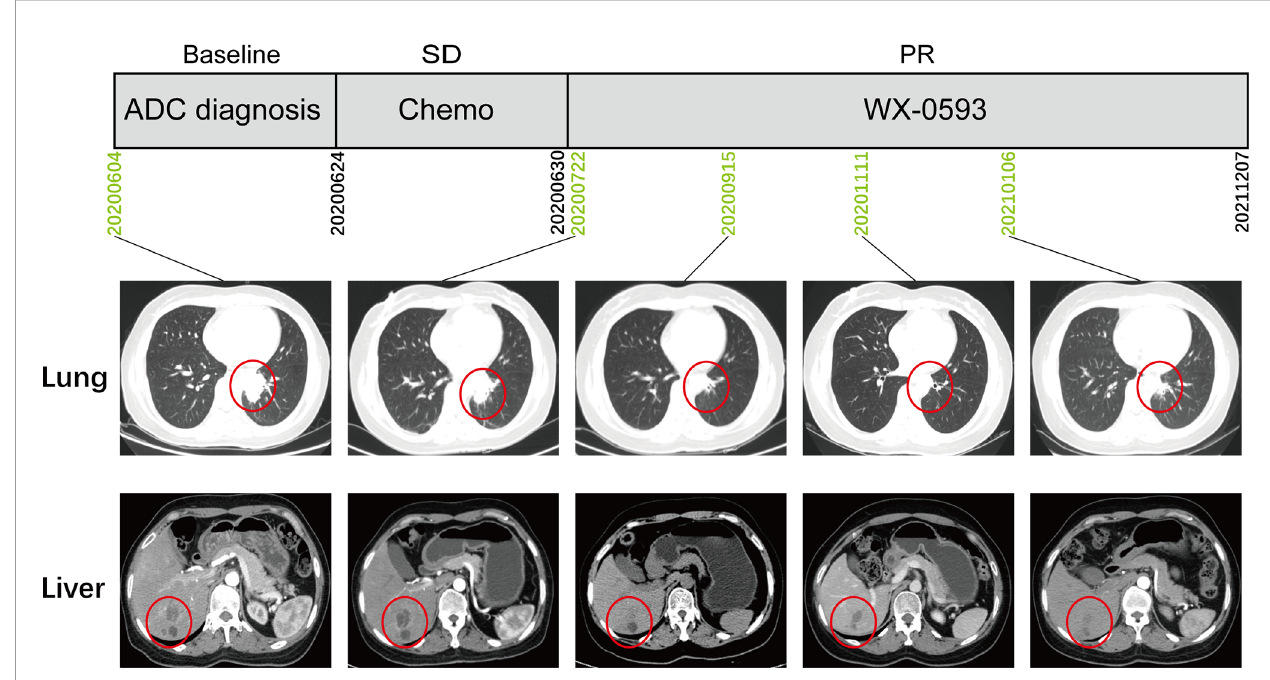
FIGURE 1 | The treatment scheme and representative CT scan images during treatment. ADC, adenocarcinoma; SD, stable disease; PR, partial